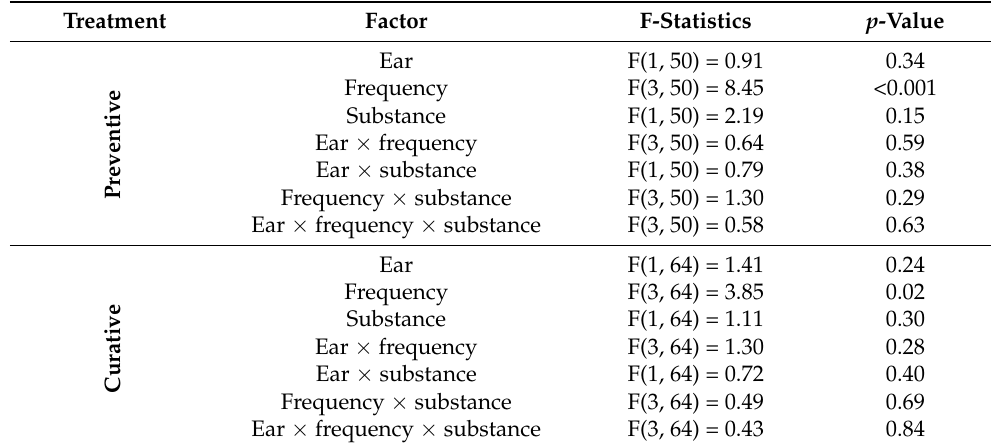
Table 1. Results of repeated measurement ANOVAs of healthy animals’ hearing thresholds in preventive and curative effect